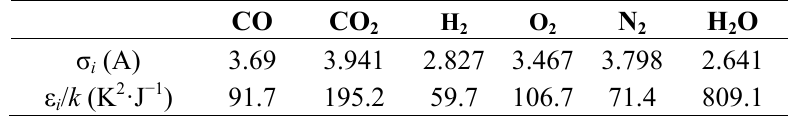
and ε / k for calculating the diffusion coefficients i i